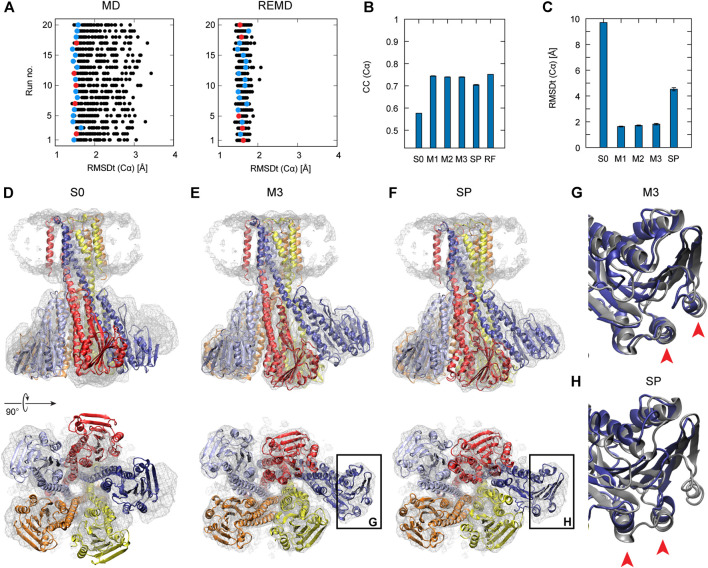
Fitting of Magnesium Transporter CorA to experimental density map. (A) RMSDt of Cα atoms of best CC models for runs of simulations without (MD) and with exchanges between replicas (REMD), respectively. 5 best models are highlighted in red. (B) Average CC of the initial structure (S0) and 5 best models in the multi-scale protocol stages (M1, M2, M3) and in the simple protocol (SP) with standard deviation as an error bar. (C) Average RMSDt of the (Cα) atoms. (D) The side view and bottom view of the initial structure with the target density map. (E) The highest CC models obtained using the multi-scale and (F) simple protocol. Panels (G, H) show the enlarged view on the chain A with the reference structure in dark gray.